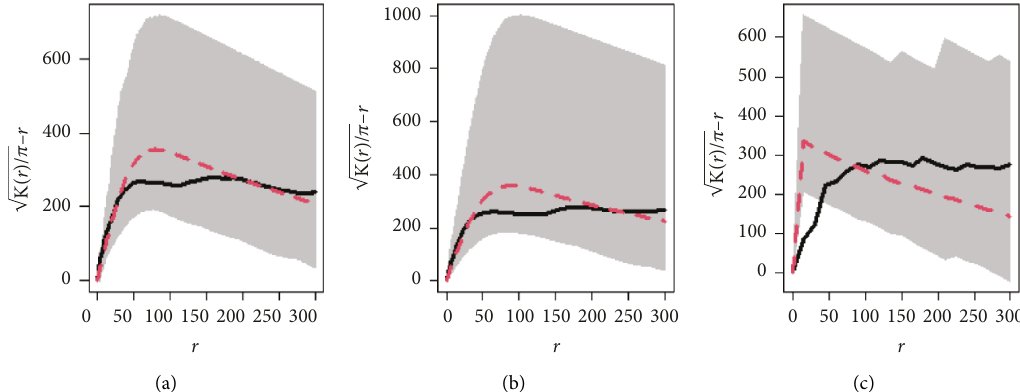
Figure 4: Spatial distribution of (a) seedlings, (b) rosettes, and (c) adults of C. parvifrons . Patterns contrasted with the null Poisson cluster (PC) model using Ripley’s K function. The gray region represents simulation envelopes constructed using 399 simulations of the PC process. The solid and dotted lines indicate the observed and expected patterns, respectively.